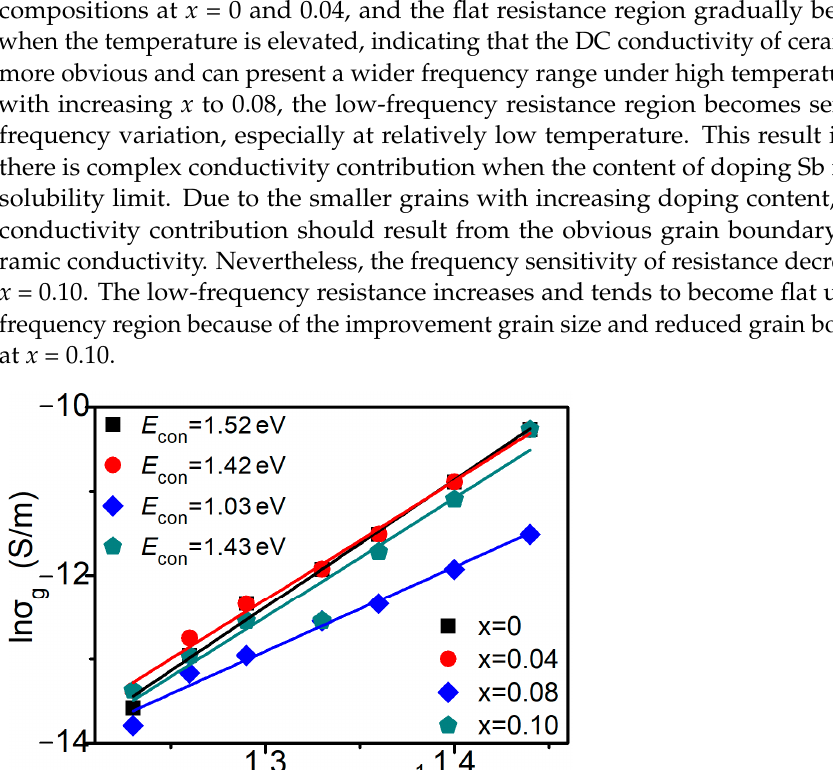
Figure 5. Temperature-dependent complex impedances for KNNS x -BNN ceramics with ( a ) x = 0, ( b ) x = 0.04, ( c ) x = 0.08 and ( d ) x = 0.10 measured at high temperature.